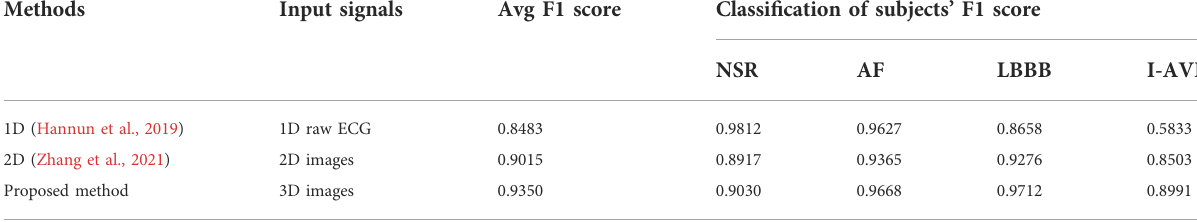
TABLE 7 Comparison of performance of the proposed 3D method VS. 2D and 1D classi fi cation methods.